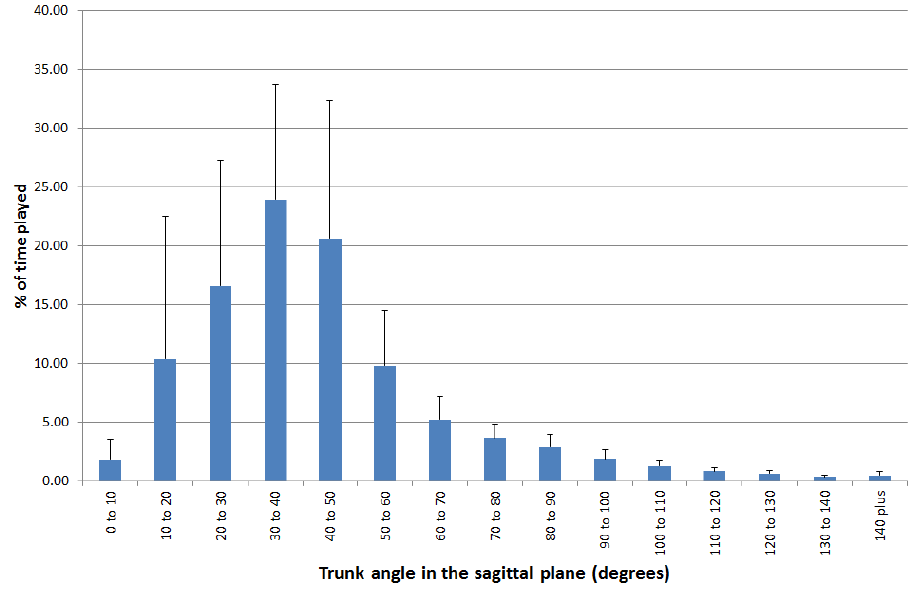
Figure 1. Range of mean trunk angles expressed during the entire